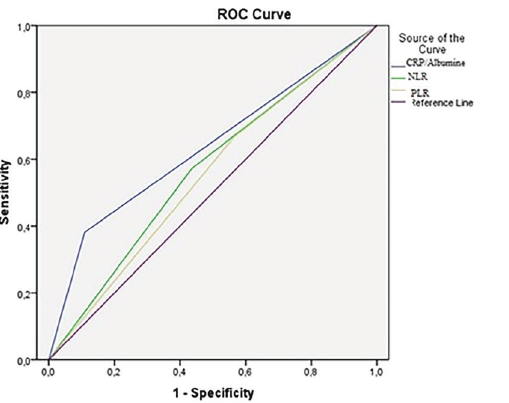
Figure 1 -ROC curve analysis NLR, PLR and CAR for DFS